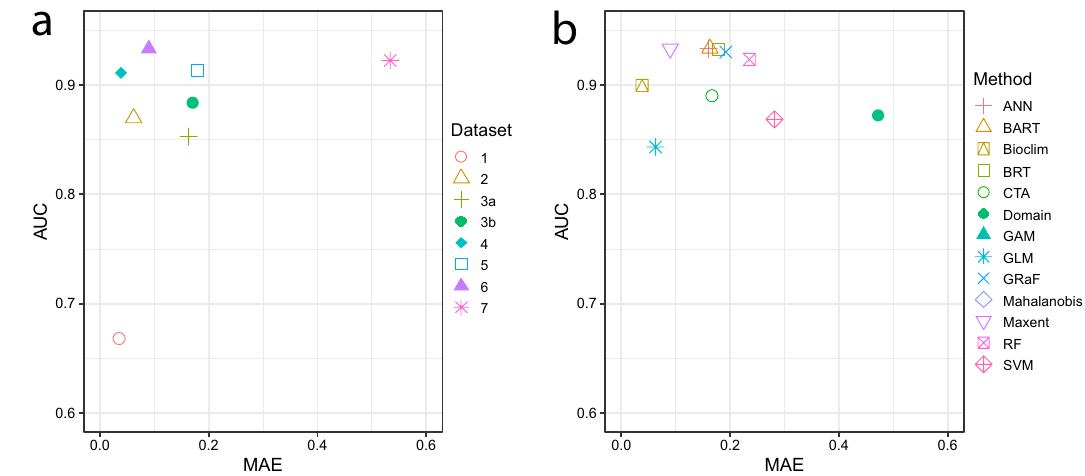
Figure 6. Example shows how AUC and MAE may be used simultaneously to select the best- performing datasets or algorithms: ( a ) selection of the best dataset for use with Maxent algorithm, ( b ) selection of the best algorithm for use with georeferenced herbarium specimens dataset (6). The best-performing dataset or model should appear in the upper left corner, i.e., have a high AUC and low MAE. In this example, the best datasets for Maxent are 4 and 6, while the best algorithm for dataset 6 is Maxent and Bioclim, or alternatively, one of the group consisting of ANN, BART, BRT, and